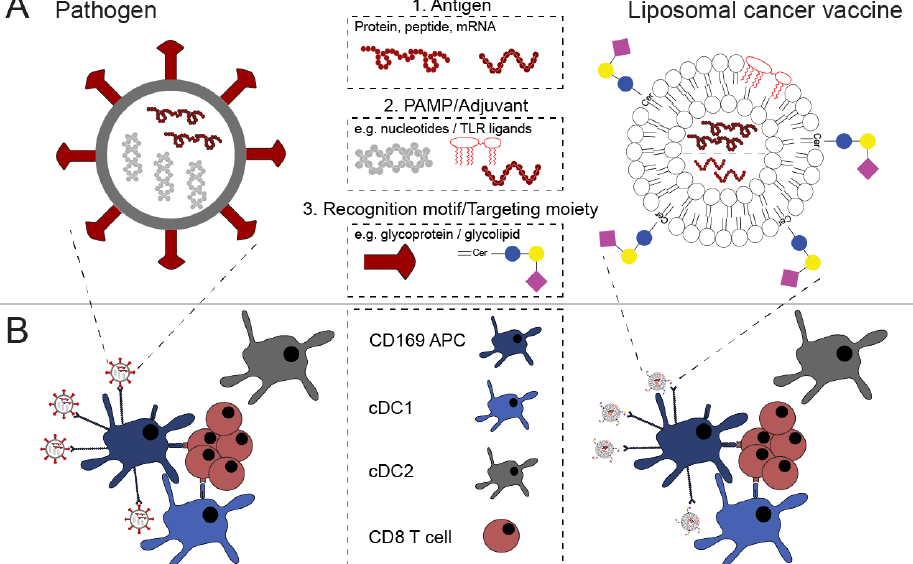
Figure 1. Pathogen mimicry of liposomal cancer vaccines augment their efficacy. ( A ) Pathogens harbor (1) antigenic proteins or peptide, from which an immune response can be elicited, (2) pathogen-associated molecular patterns (PAMPs) that activate the immune system, and (3) recognition molecules that allow for uptake by host cells. Liposomal cancer vaccines mimic pathogens by incorporation of (1) antigens, for example, protein/peptide, or mRNA, (2) TLR ligands or nucleotides to activate the immune system, and (3) modification of the liposomal surface with targeting moieties that allow for tailored interactions between the liposomal vaccine and immune cells. ( B ) Upon pathogen challenge or liposomal cancer vaccination, designated APCs take up and subsequently cross-present antigen in MHC class I to induce potent immune responses. Liposomal cancer vaccine mimicry can optimize vaccine interaction with the immune system that subsequently translates to robust antigen-specific immune responses.